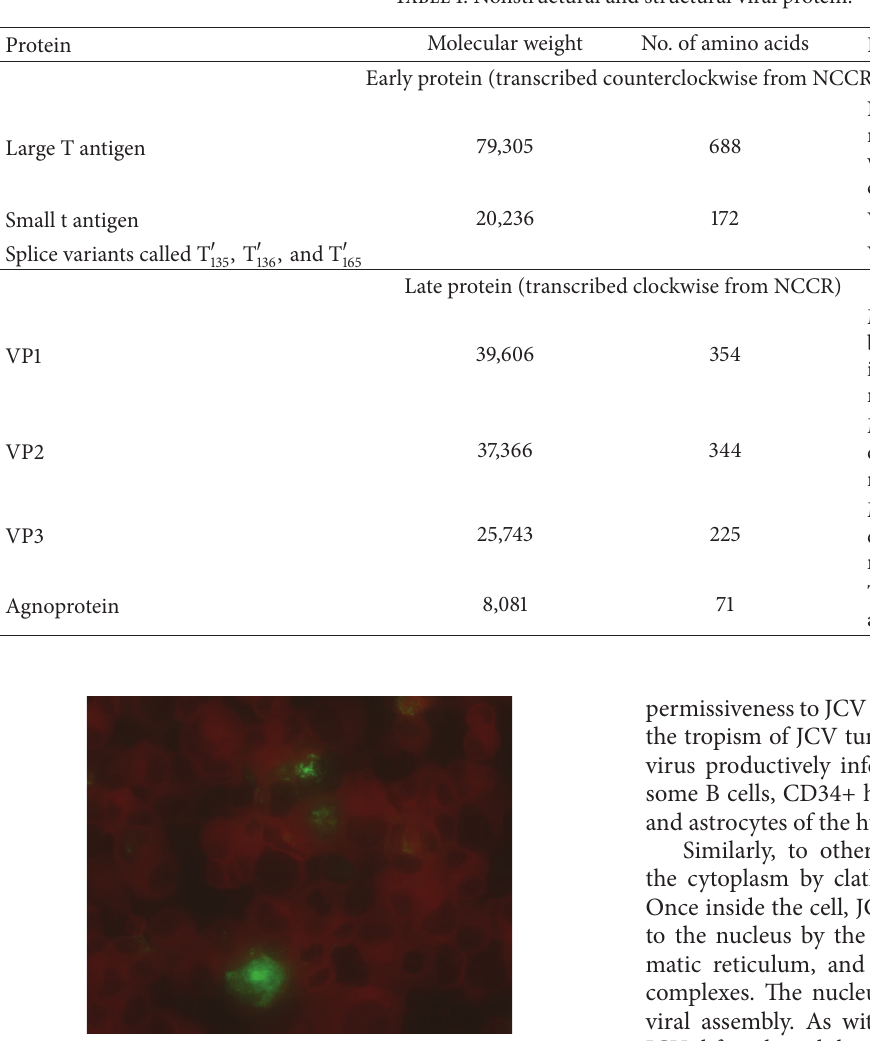
Figure 2: Immunofluorescence staining of COS7 infected by JCV (Mad4), five day after infection. The cells were stained with anti-VP1 monoclonal antibody (green-stained cells) and counterstained with Evans blue (red-stained